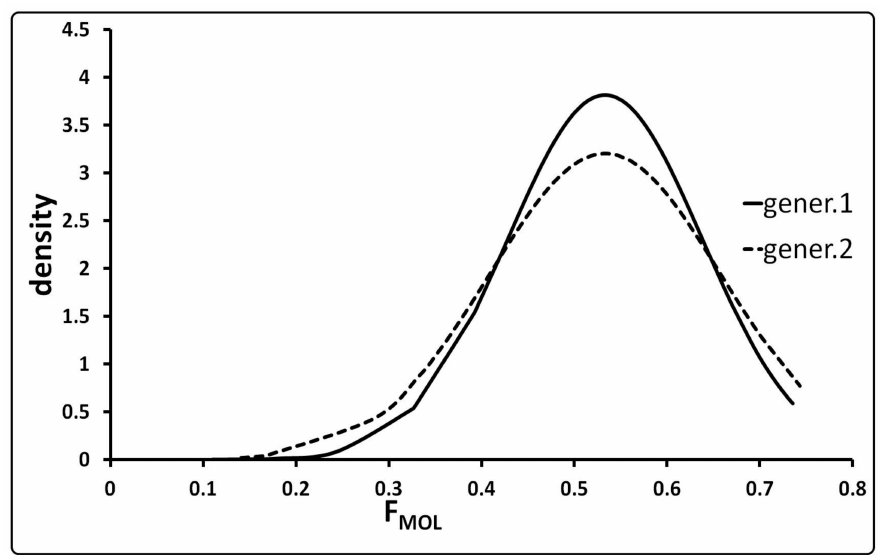
Figure 1. Distribution of the F MOL (inbreeding coefficient using molecular polymorphisms) values in generations 1 and 2 of Nero Lucano pig.